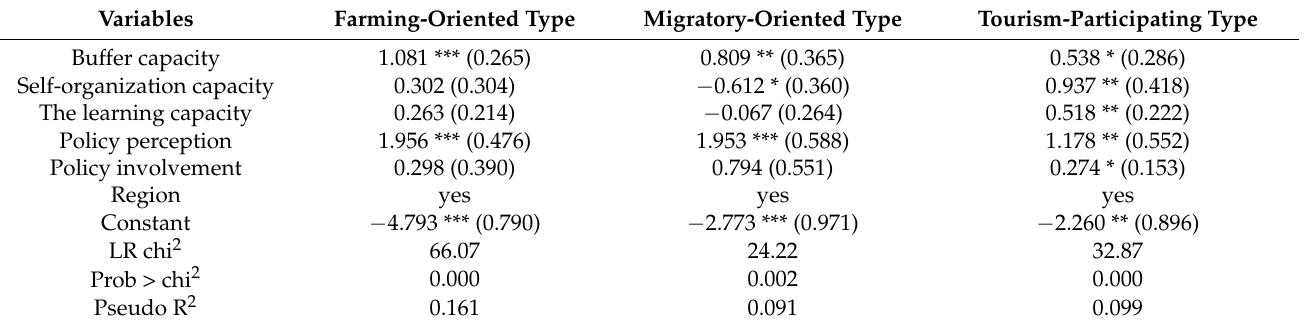
Table 5. Differences in the influencing factors of different types of rural households’ willingness to participate in rural tourism.